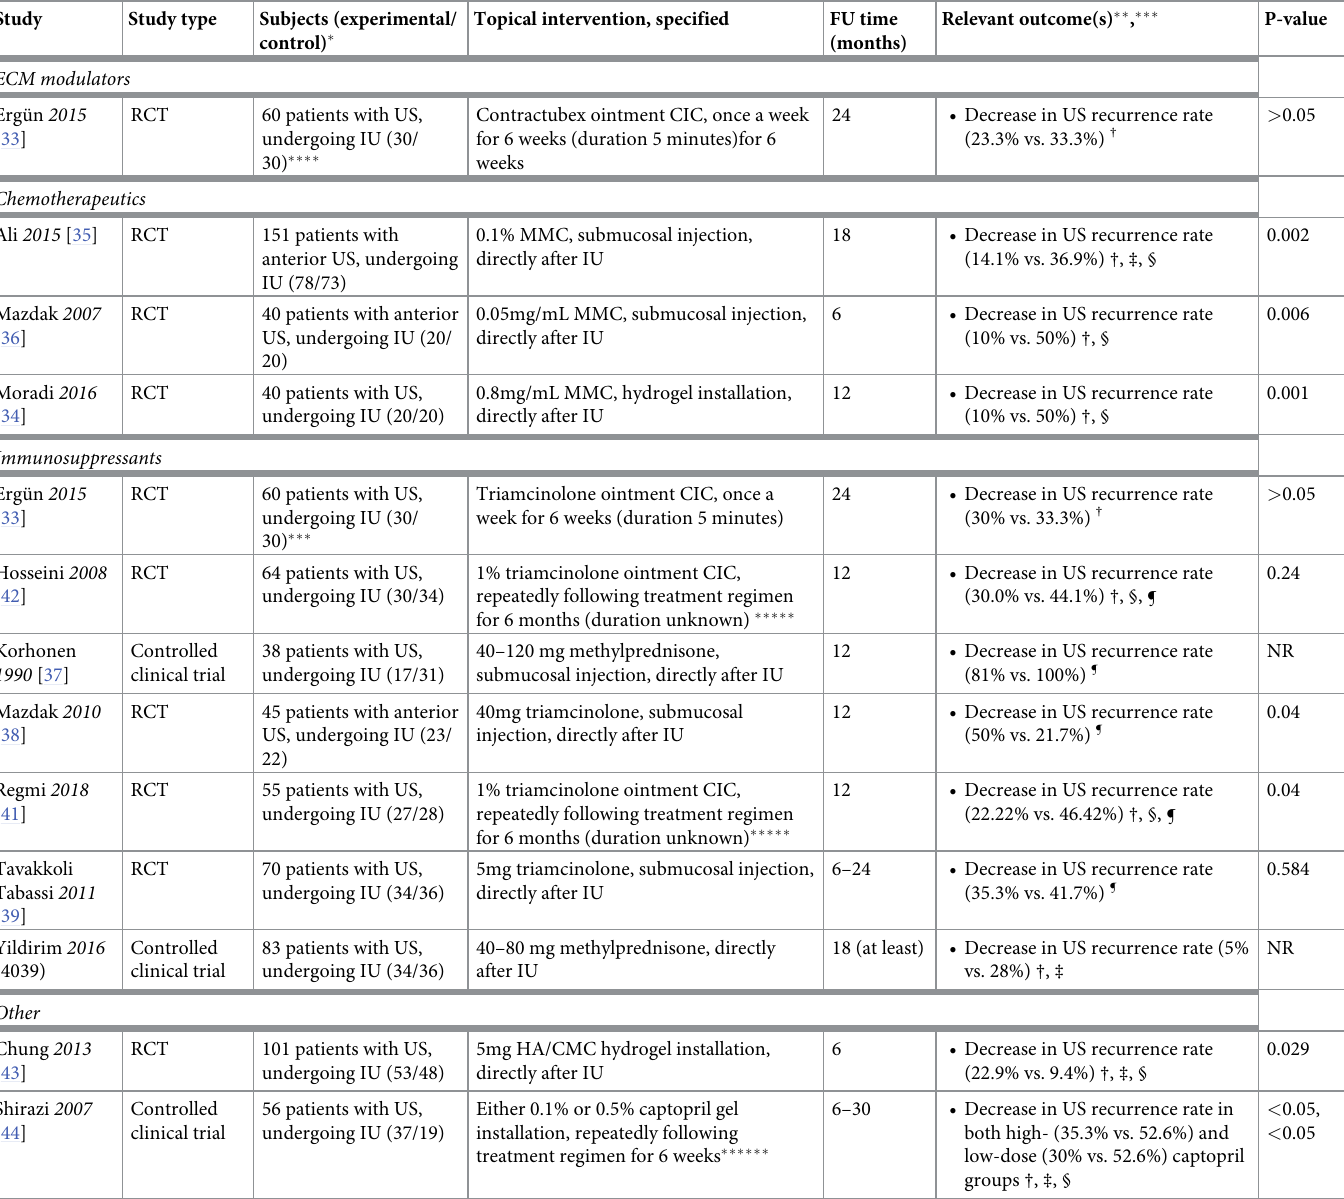
Table 2. Overview of clinical study